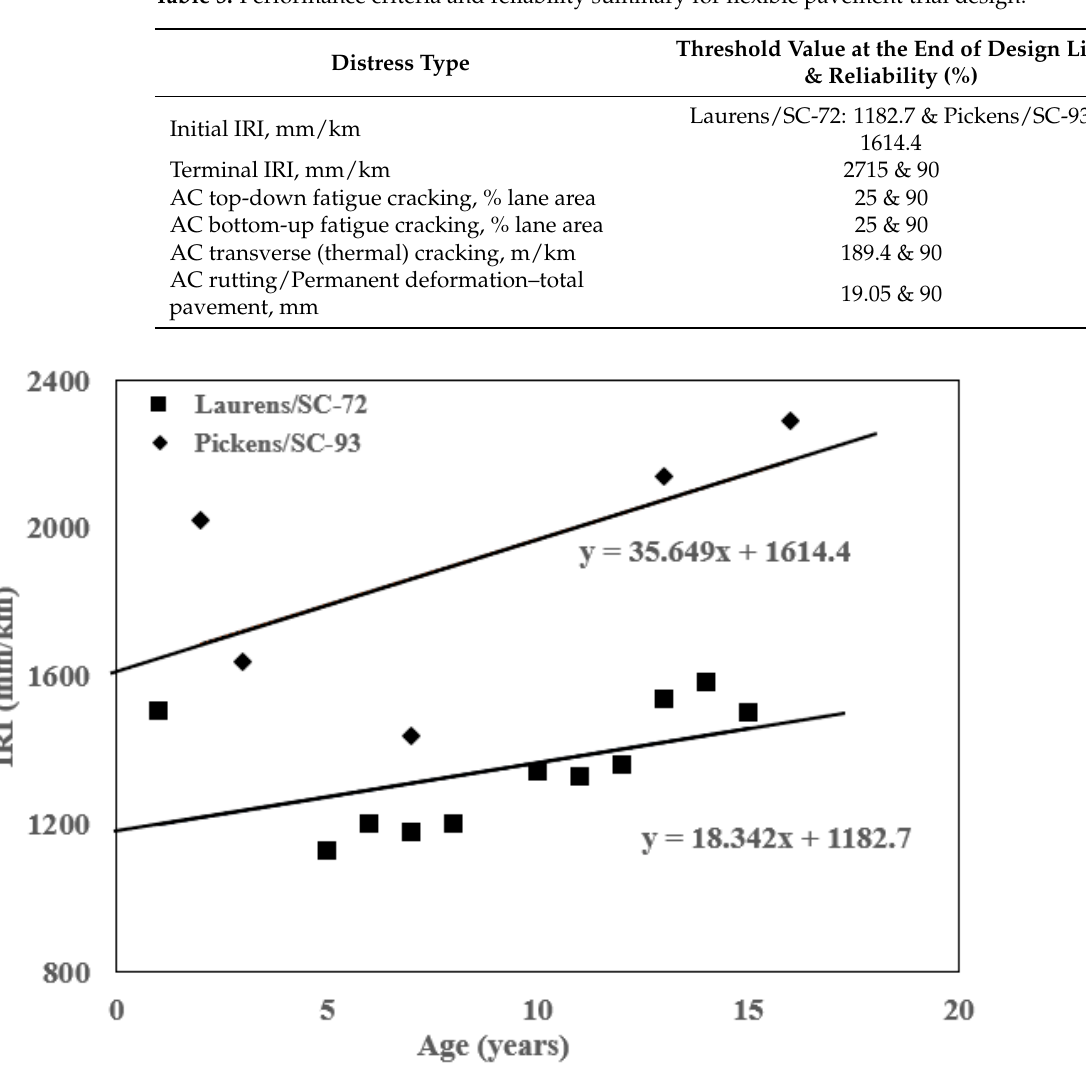
Table 5. Performance criteria and reliability summary for flexible pavement trial design.